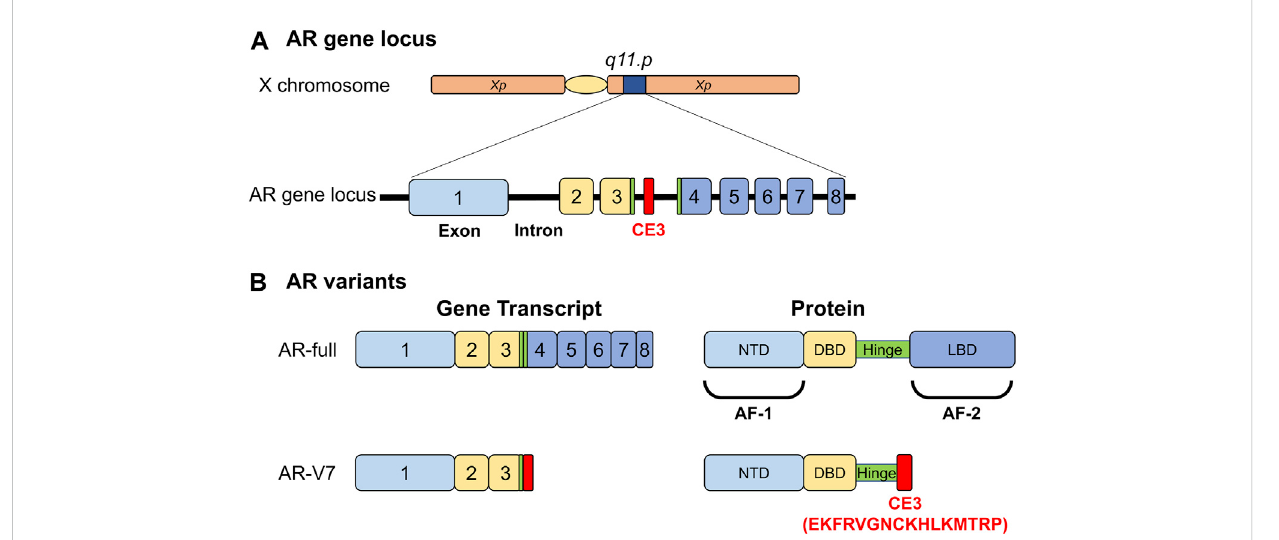
FIGURE 1 Functional structures of androgen receptor (AR) and its variant (AR-V7) selectively emerging in malignant prostatic tumors. (A) The human gene locus of the androgen receptor. CE; AR-V7- speci fi c exon. (B) Functional structure of AR and AR-V7. NTD; N-terminal end: DBD; DNA-binding domain: LBD; Ligand-binding domain: AF-1; Autonomous transactivation function-1: AF-2; Autonomous transactivation